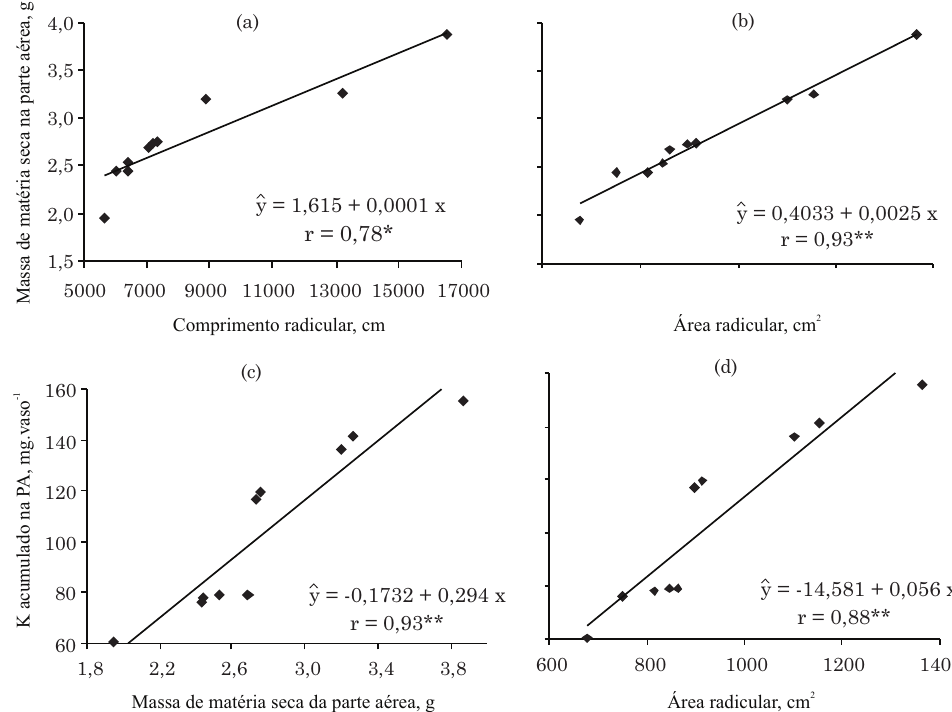
Figura 1. Correlações entre a massa de matéria seca (MS) da parte aérea (PA) e o comprimento de raiz (a); MS da PA e área radicular (b); quantidade de potássio acumulado na PA e MS da PA (c); e quantidade de potássio acumulado na PA e área radicular (d) de genótipos de arroz irrigado. ** e *: significativo a 1 e 5 %,